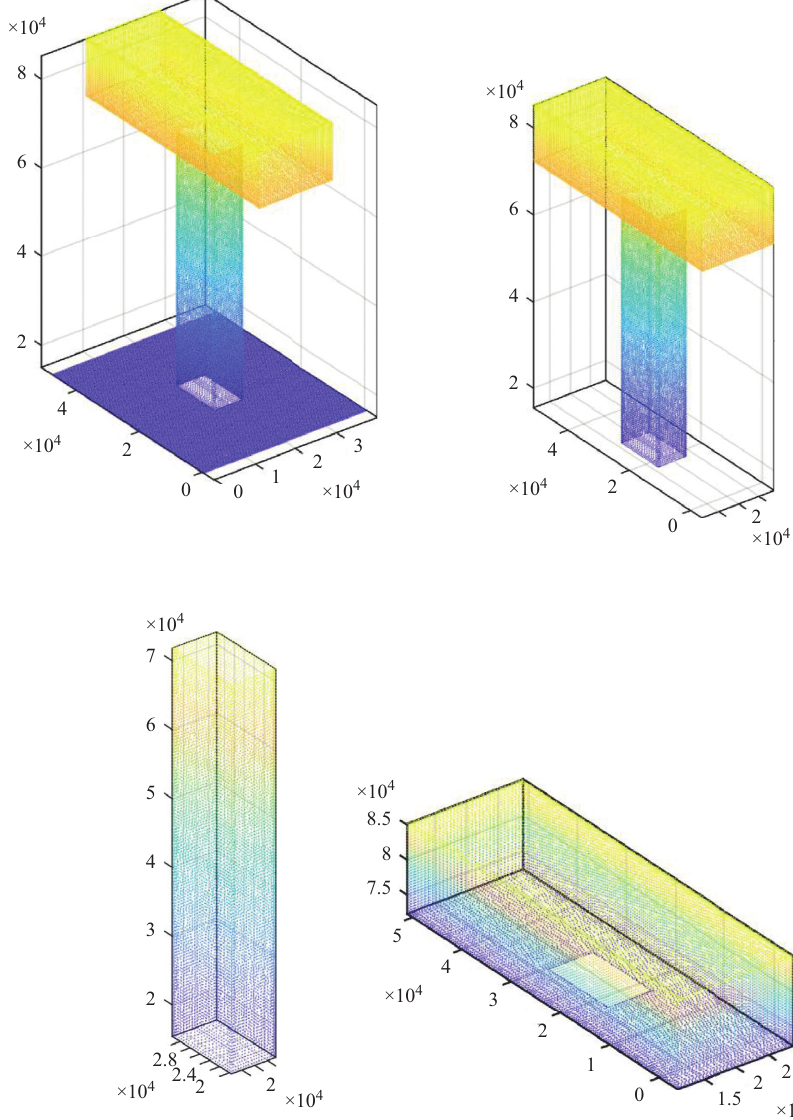
Figure 5: Point cloud after segmentation of the first